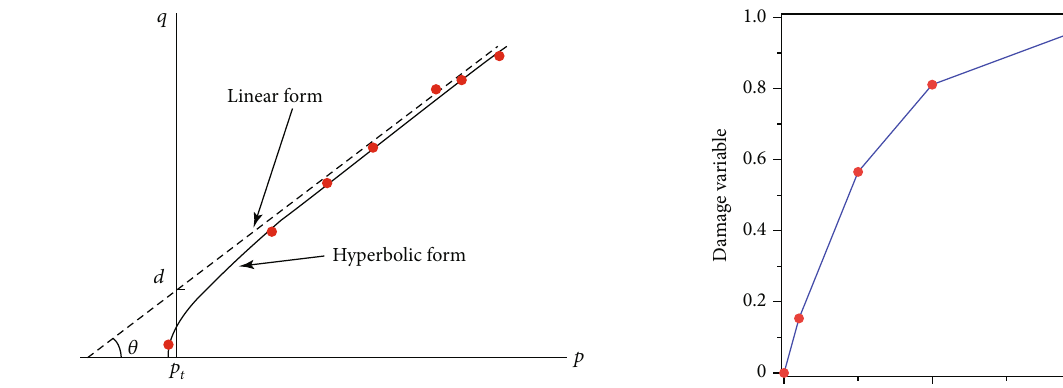
Figure 10: Comparison of the linear form and hyperbolic form of Drucker-Prager criterion in the p ~ q plane.